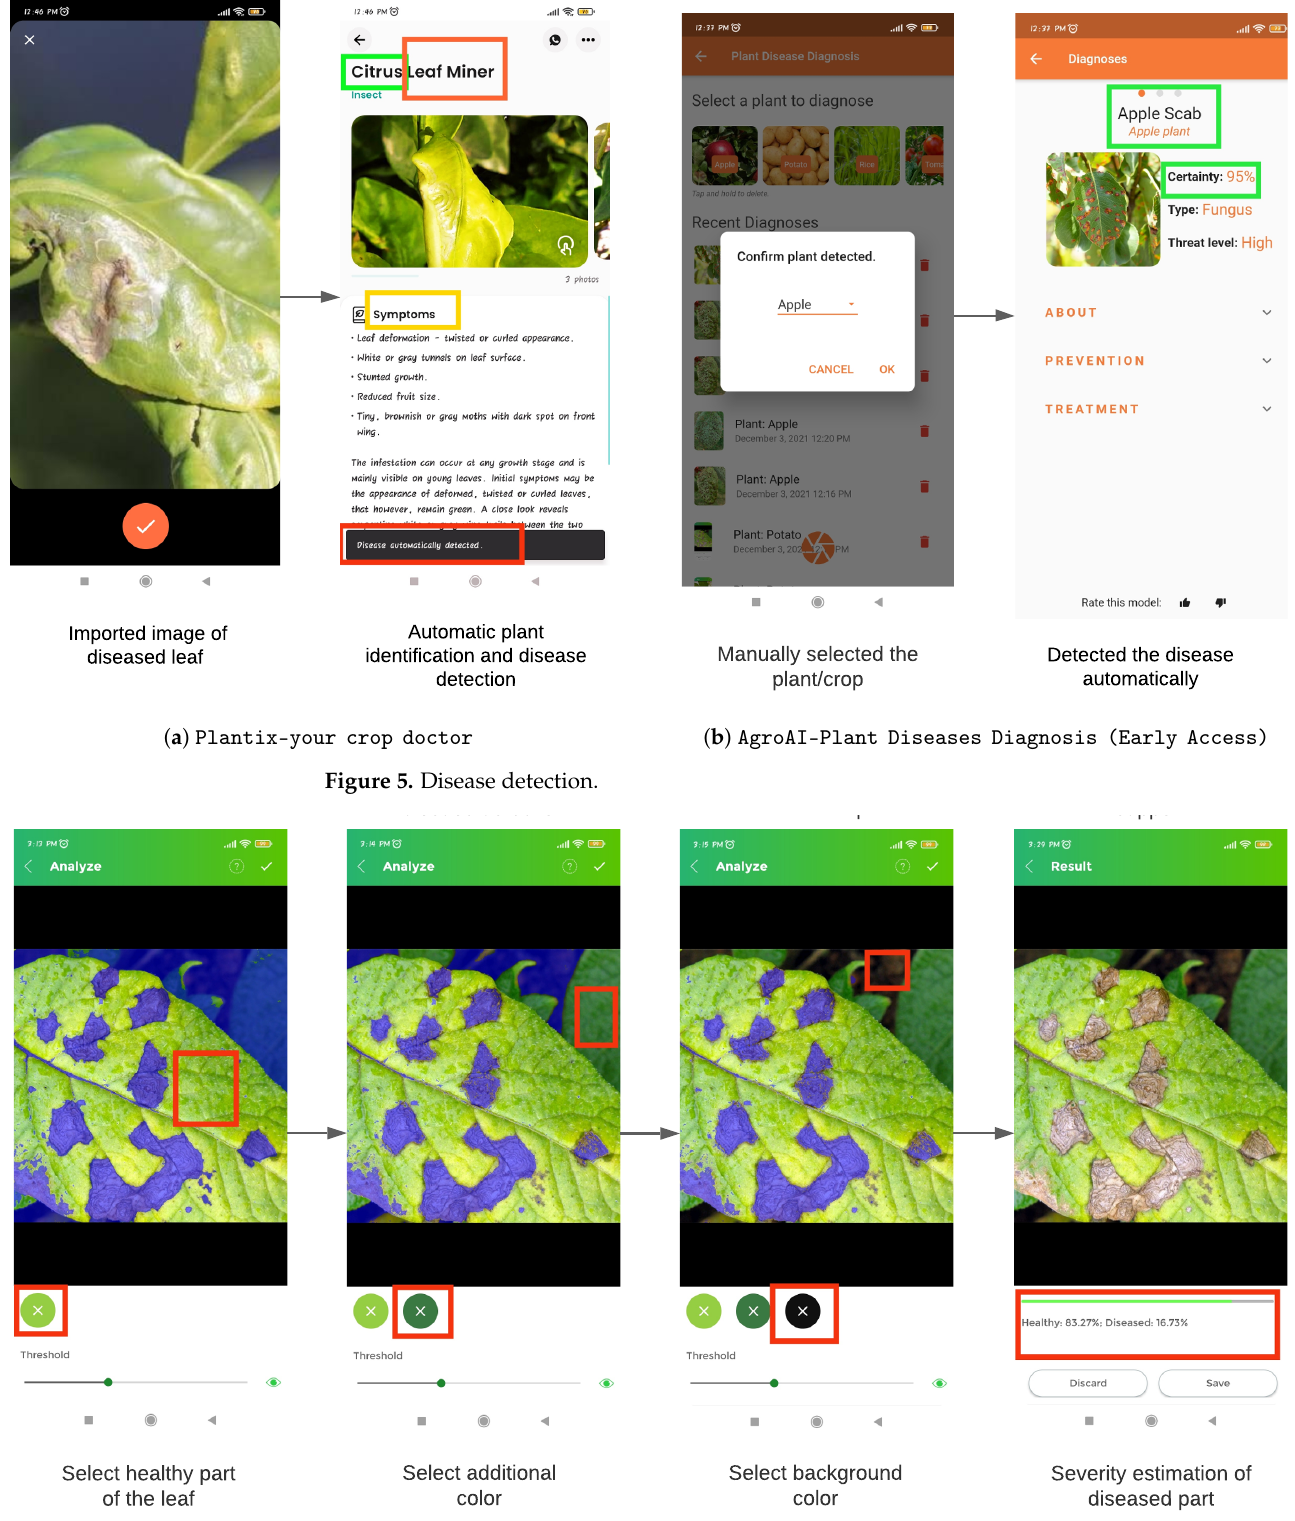
Figure 6. Severity detection and visualizing the infected area of the diseased leaf by Leaf Doctor